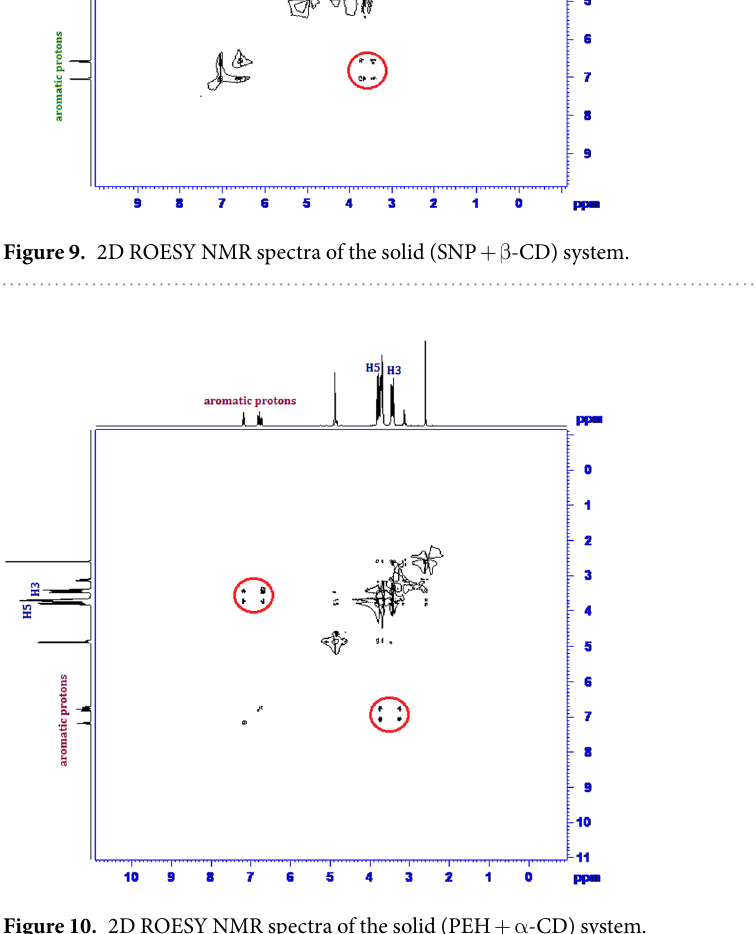
Figure 10. 2D ROESY NMR spectra of the solid (PEH + α -CD)